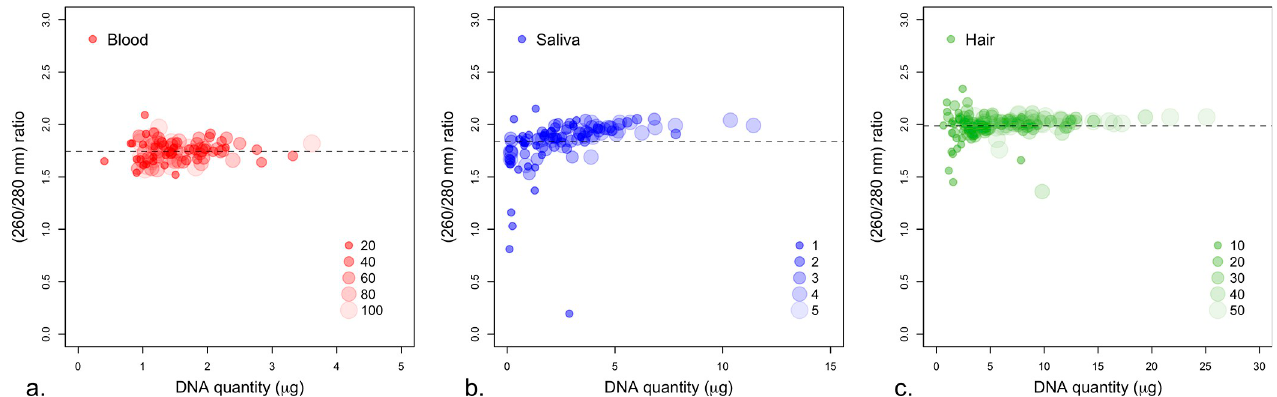
Fig 2. Quantity and purity of camel DNA extracted from whole-blood, saliva, and tail-hair follicles. (a-c) DNA quantity ( μ g) on the x-axis and 260/280 nm ratio on the y-axis from whole-blood, buccal swabs, and tail-hair follicles, respectively. Each circle corresponds to a measurement (DNA quantity and 260/280 nm ratio) from the first elution (E1 = 100 μ l) and the size of the circle represents the different amounts of starting material (blood = 20, 40, 60, 80, 100 μ l, saliva = 1, 2, 3, 4, 5 swabs, hair = 10, 20, 30, 40, 50 follicles). Dashed horizontal lines are the mean 260/280 nm ratio.